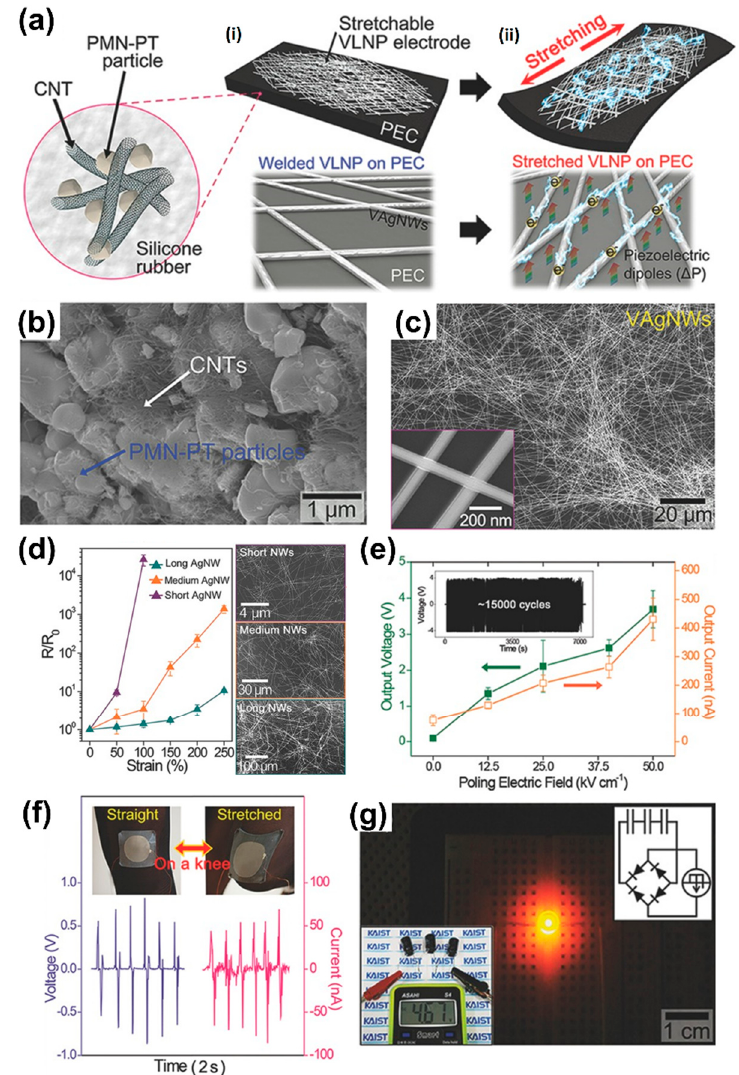
Figure 4. ( a ) Schematic diagram of the hyper-stretchable and deformable NCG. ( a - i ) VAgNWs transferred onto both sides of PEC made of PMN − PT particles, MW − CNTs and Si − rubber matrix for the fabrication of stretchable electrodes. ( a - ii ) Generation of electricity of SEG when it is stretching and deforming. The bottom figures show magnified schematics of welded VLNP and stretched VLNP on PEC. ( b ) SEM image of well − dispersed PMN − PT particles and MW − CNTs. ( c ) Overall and magnified (inset) SEM images of VAgNWs synthesized by SMG method. ( d ) The change of relative resistance with strain for short AgNW, medium AgNW and long AgNW percolation network electrodes, calculated by a COMOSOL simulation. ( e ) Generated output voltage and current versus polling electric field of the stretched SEG device. The durability test of SEG for 15,000 cycles (inset). ( f ) The voltage and current are generated from SEG on the stocking by bending and straightening the knee. ( g ) Photograph shows a commercial LED bulb turned on by the stored energy in capacitors (bottom inset), charged by generated energy from SEG. Reproduced with permission [68].